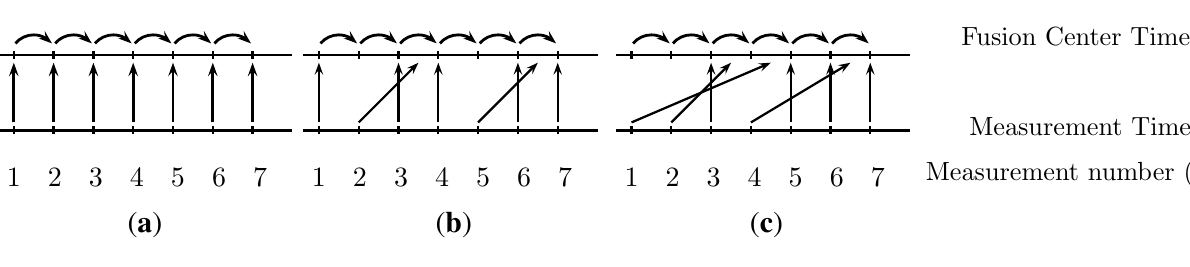
Figure 1. Out-Of-Sequence Problem. ( a ) Non-delayed data; ( b ) 1-step lag delay data; ( c ) N-step lag delay